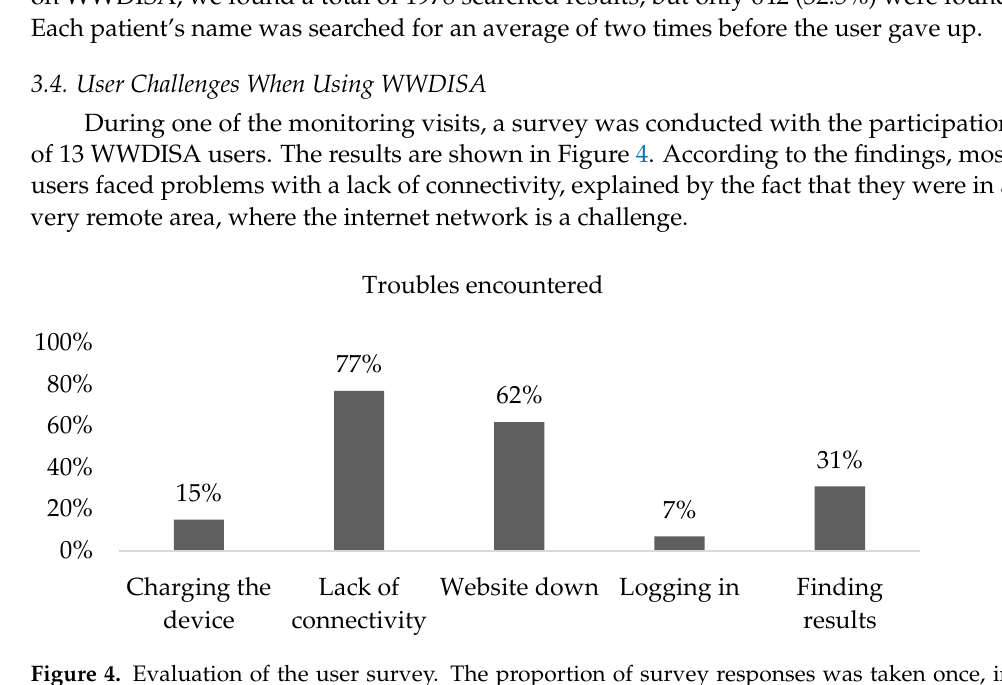
Table 1. Turn-Around Time in phases of the referencing chain according to the Viral Load.